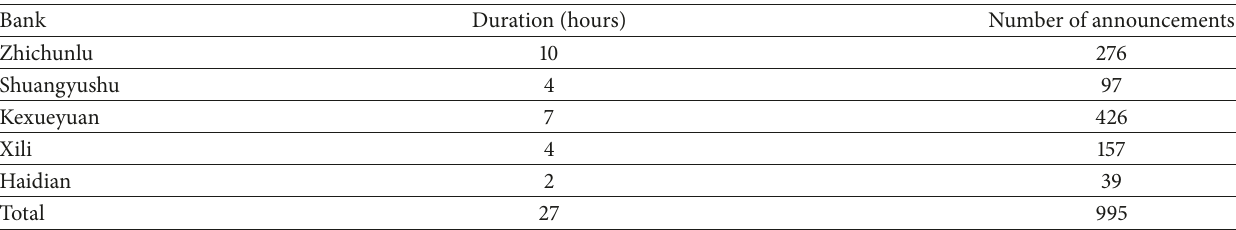
Table 1: Information of experimental data.